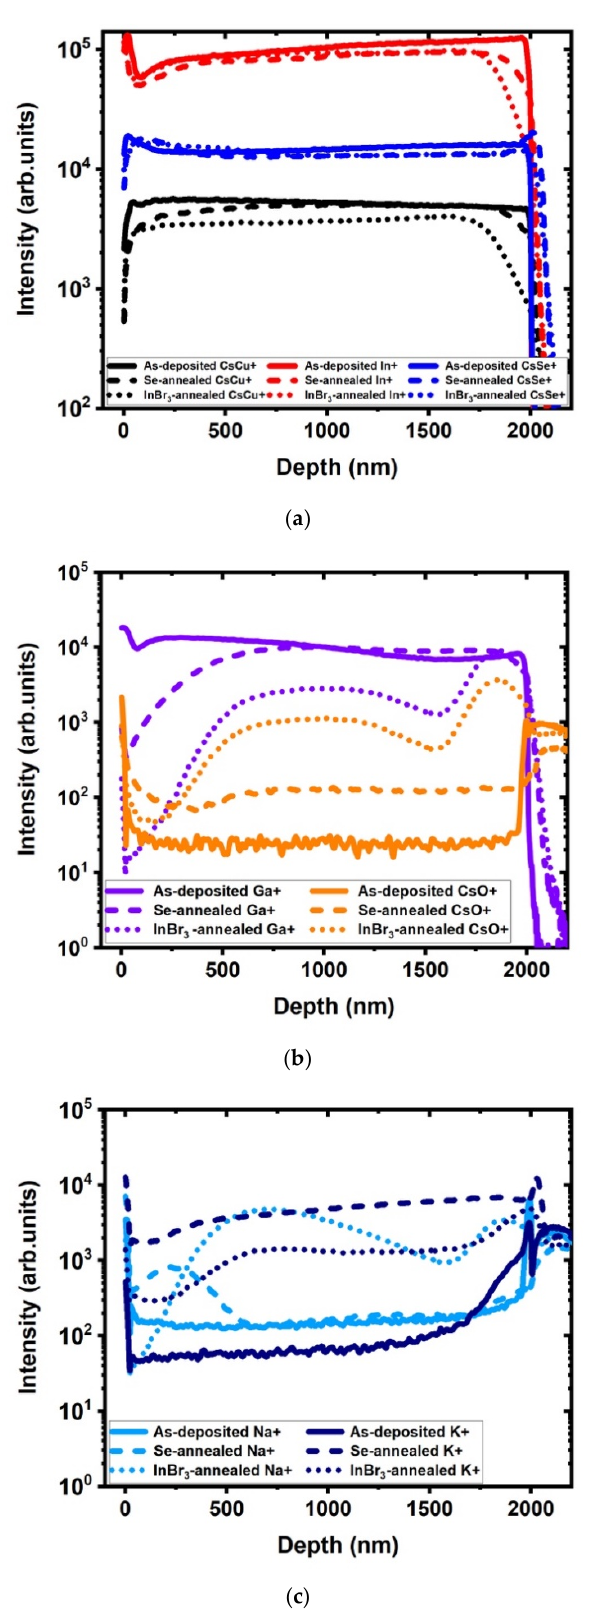
Figure 6. Secondary ions mass spectrometry (SIMS) depth profile (positive ions) for the as-deposited, Se-annealed, and InBr 3 annealed at 500 ◦ C CIGS samples: ( a ) Cu, In, and Se ions; ( b ) Ga and O ions; ( c ) alkali ions (as-deposited: full line; Se annealed: dashed line; InBr 3 annealed: dotted